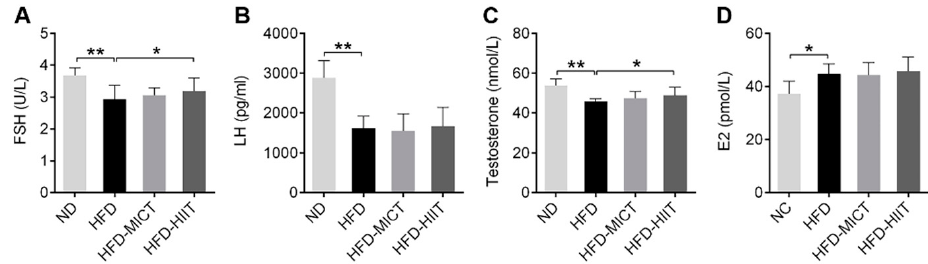
Figure 3. Effects of MICT and HIIT on serum levels of FSH, LH, testosterone and E2 in obese mice. ( A ) FSH, ( B ) LH, ( C ) testosterone and ( D ) E2 were detected in serum. Data are expressed as mean ± SEM. * p < 0.05, ** p < 0.01.